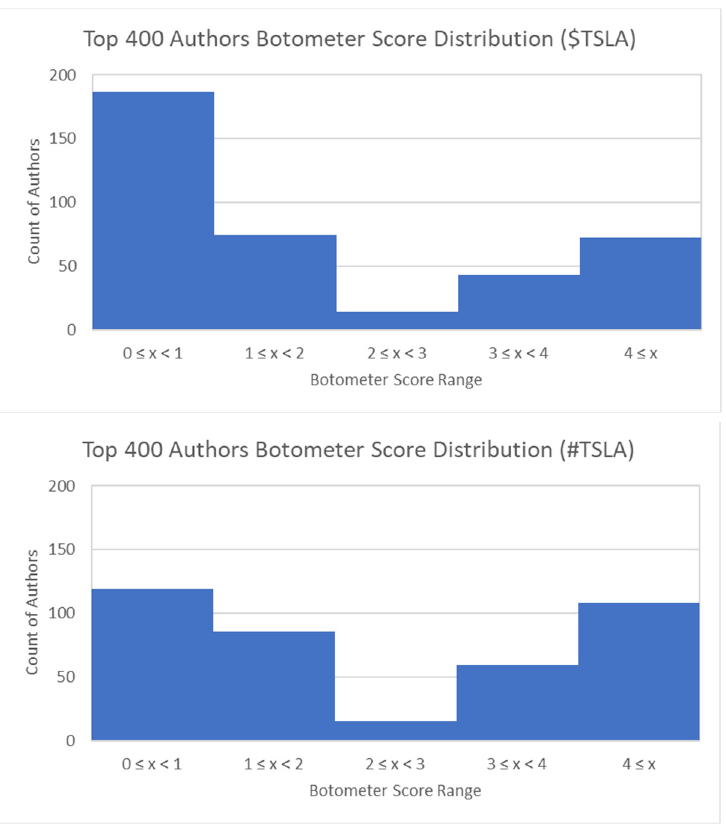
Figure 3. Histogram of the 400 most active $TSLA and #TSLA users by Botometer score. Over the study period, there were a total of nearly 4.3 million tweets containing $TSLA. Of these tweets, approximately 1.4 million (or 33%) were posted by the 400 most active $TSLA accounts and more than 400,000 (or 10%) by accounts identified by Botometer as Fanbots. Over the same period, there were approximately 157,000 tweets containing #TSLA. Of these tweets, nearly 66,000 (or 42%) were posted by the 400 most active #TSLA accounts and 36,000 (or 23%) by accounts identified by Botometer as Fanbots. We interpreted the magnitude and share of CCP in the $TSLA and #TSLA Twitter corpora to be significant (see Figure 4).